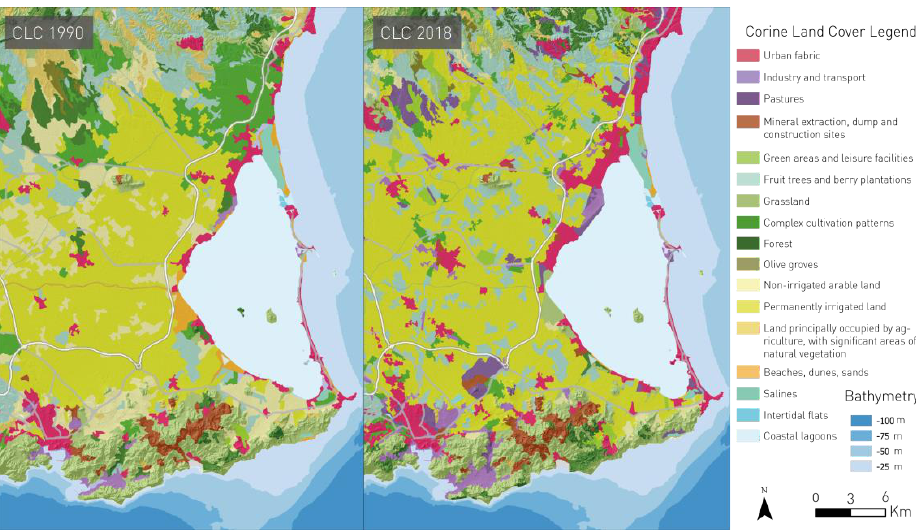
Figure 1. Location of the Mar Menor coastal lagoon on the southeastern coast of Spain and Senti- nel-2 image captured on 21 March 2021 indicating the final transect of the Albujon watercourse flowing into the lagoon.